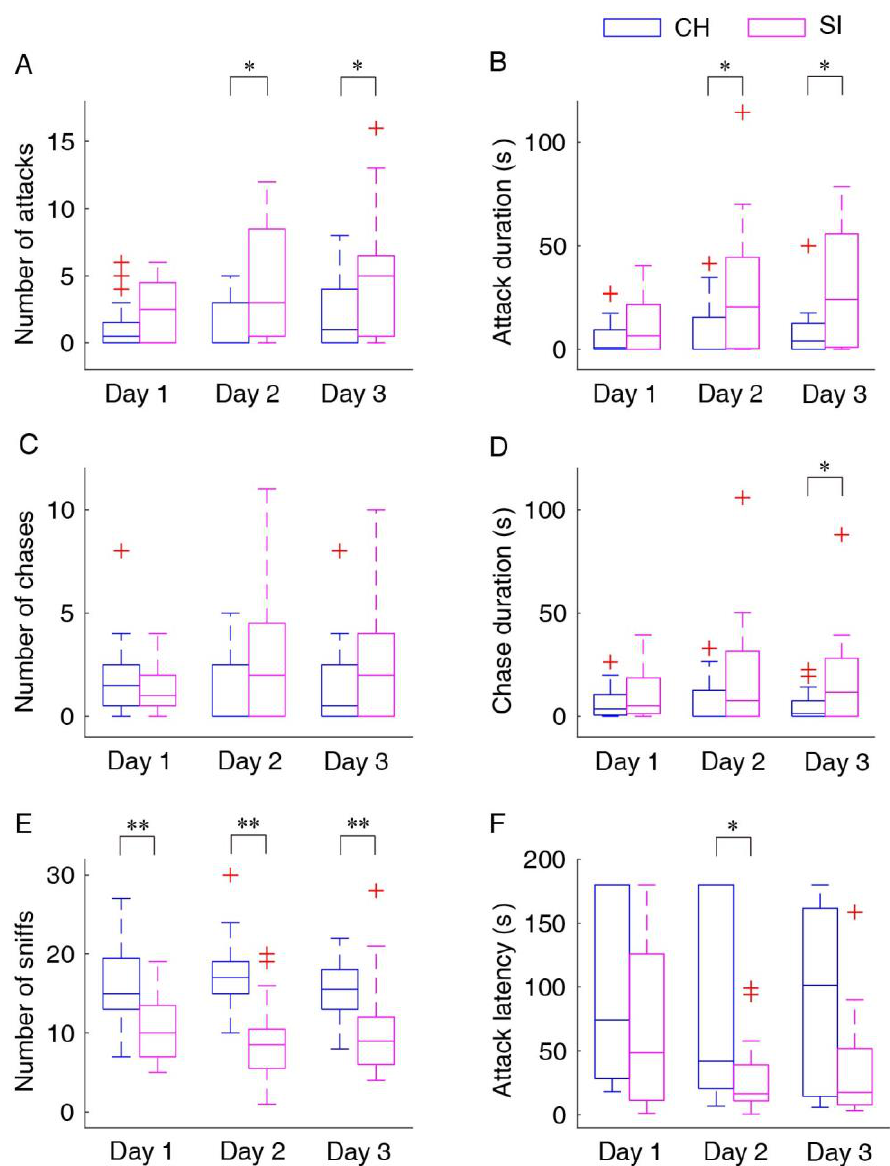
Figure 2. Statistical results for different behavioral parameters: number of attacks ( A ), attack duration ( B ), number of chases ( C ), chase duration ( D ), number of sniffs ( E ) and attack latency ( F ). Data points beyond the whiskers are displayed using red +. SI, the socially isolated mice; CH, the cohousing mice; Day 1 – 3, the three consecutive days for the resident – intruder test. * p < 0.05; ** p < 0.001.